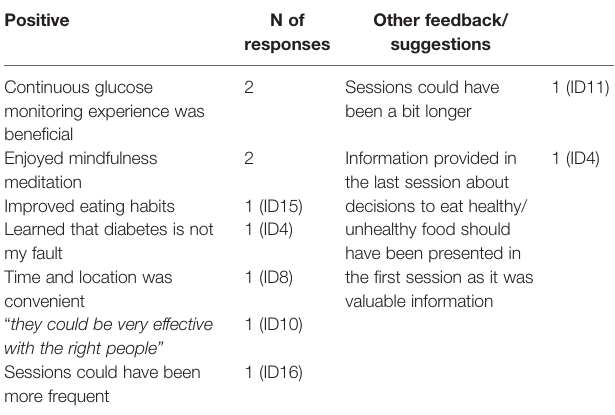
TABLE 4 | Acceptability of trial procedures from the exit questionnaire. TABLE 3 | Additional overall feedback about pSMAs from exit